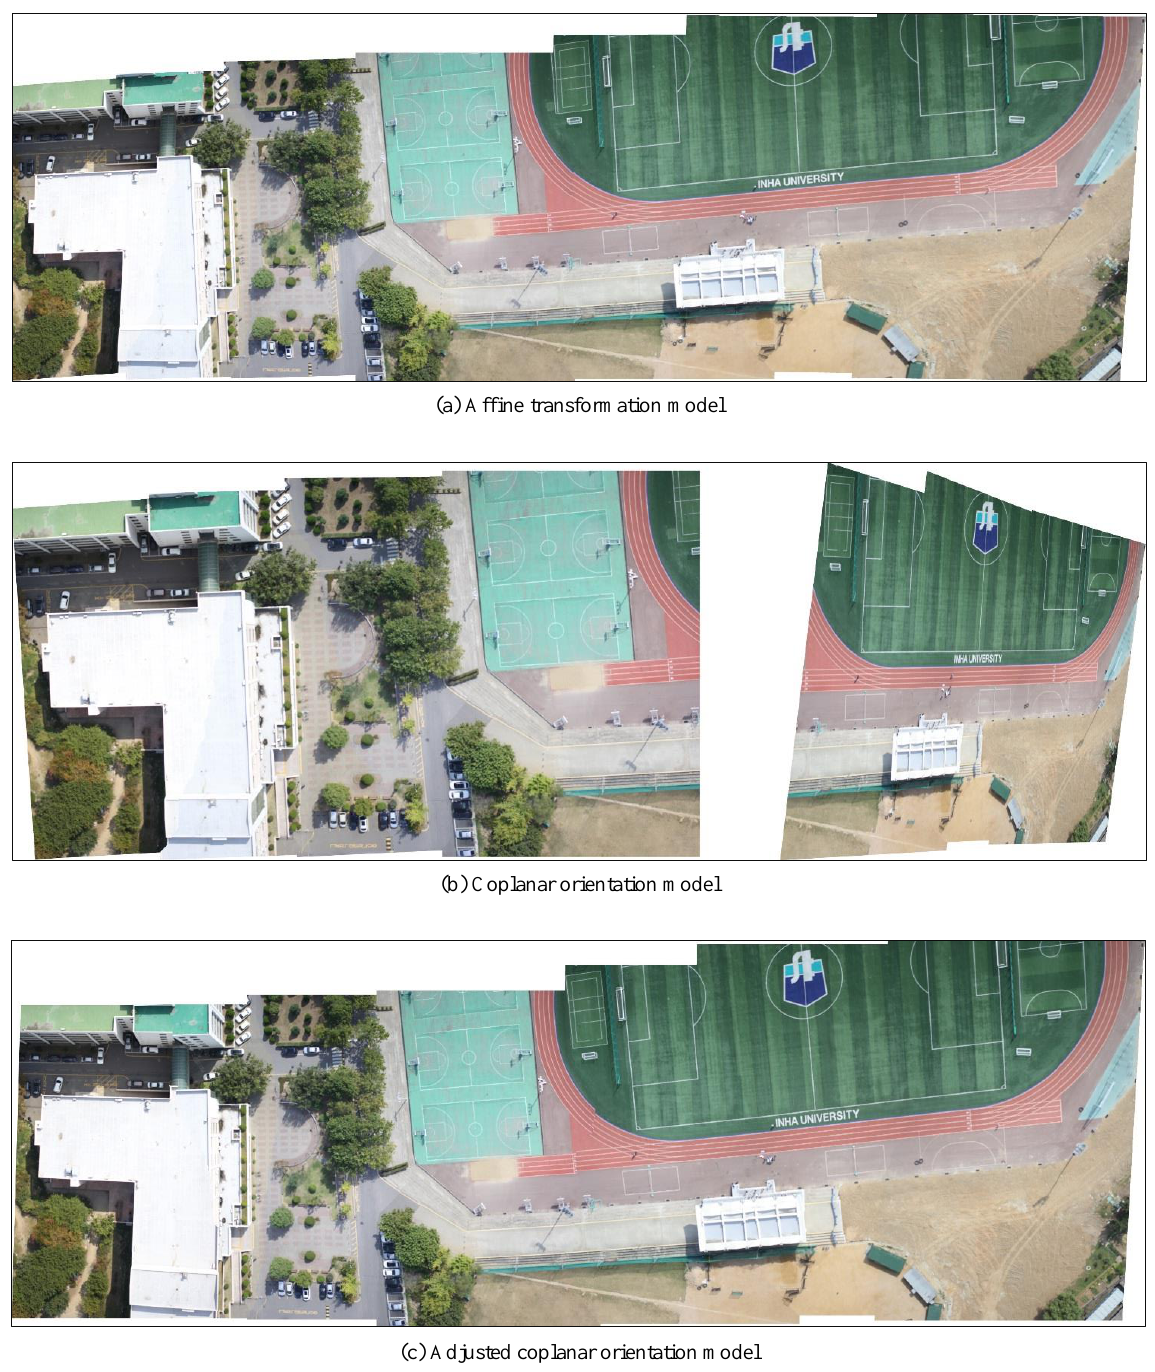
Figure 6. Image mosaicking result of strip